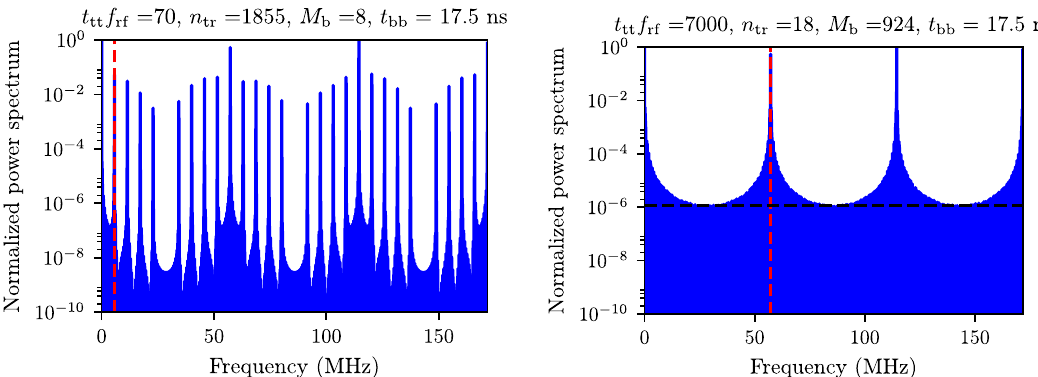
. The right-hand side plot is the case of long trains. The red line is at 1 =t tt